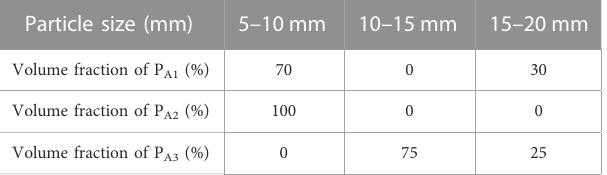
TABLE 7 Volume fraction of each particle size in the sample.